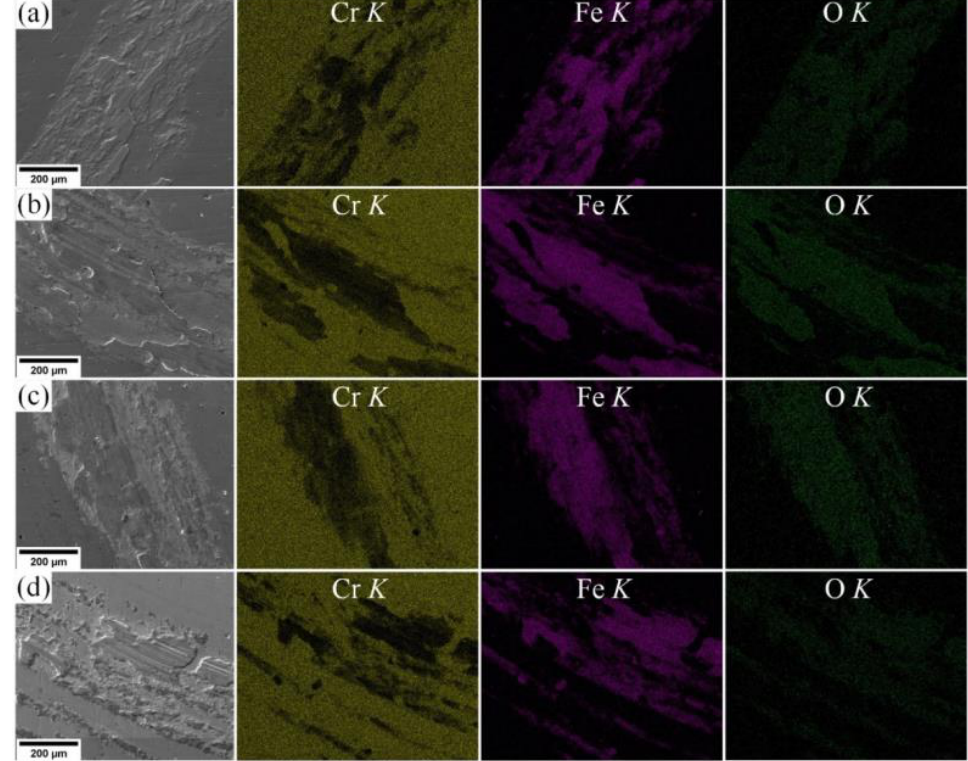
Figure 8. SEM images of wear tracks and distribution of chromium, iron and oxygen in coatings: ( a ) S1 (Al/Cr = 1.2), ( b ) S2 (Al/Cr = 0.8), ( c ) S3 (Al/Cr = 0.5), ( d ) S4 (Al/Cr = 0.2).